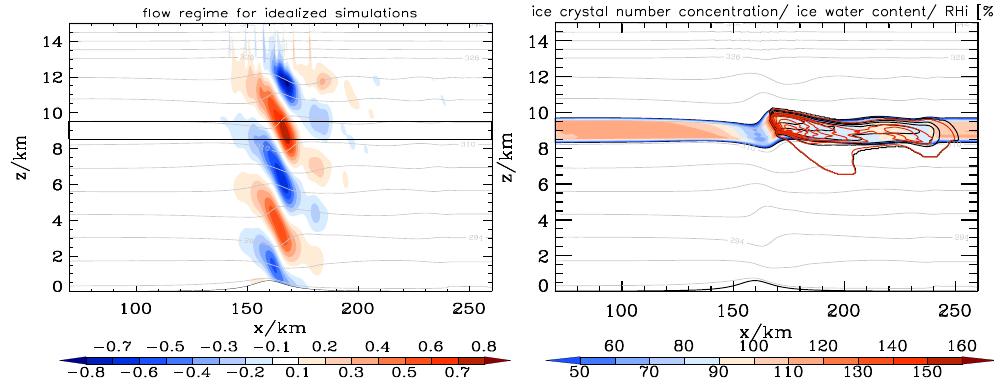
Figure 1. Flow regime after 5h used for the idealised simulations HOM (left). Grey lines indicate lines of constant potential temperature with an increment of 4K. The black rectangle shows the position of the ISSR. Colours indicate the vertical velocities (left) and the relative humidity with respect to ice (right). Black contours show the ICNC with the lines for 0.00001, 1, 10, 100, 500 and 1000L − 1 and red contours the IWC with lines for 0.0001, 1, 3, 6, 9, 12, 15 and 18mgm − 3 for the simulation HOM. Taken from Joos et al. (2009).